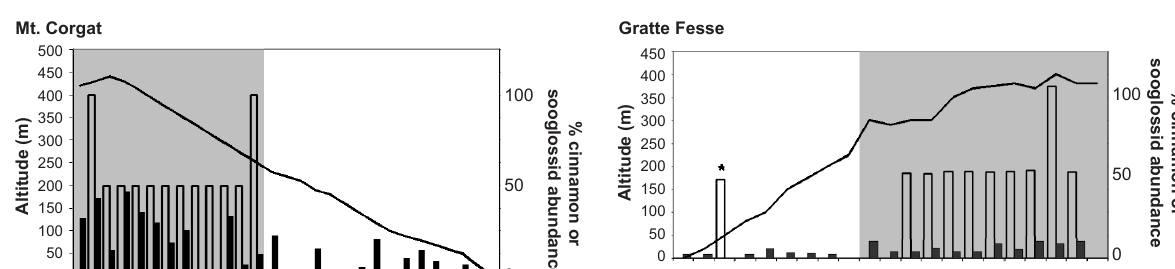
Figure 2. Sooglossid populations, climate and levels of invasion by Cinnamomum verum along transects to Mont Corgat and Gratte Fesse. White bars - sooglossid density recorded as 0 (absent), 50 (low density - heard but not quantifiable), 100 (moderate to high - recorded in quadrats). Black bars - percentage of Cinnamomum trees. Shading - climatically suitable areas are shaded. A boulder field site with an exceptionally low altitude population of sooglossids is marked with an asterisk on the Gratte Fesse transect, this has a suitable microclimate in a generally unsuitable zone.